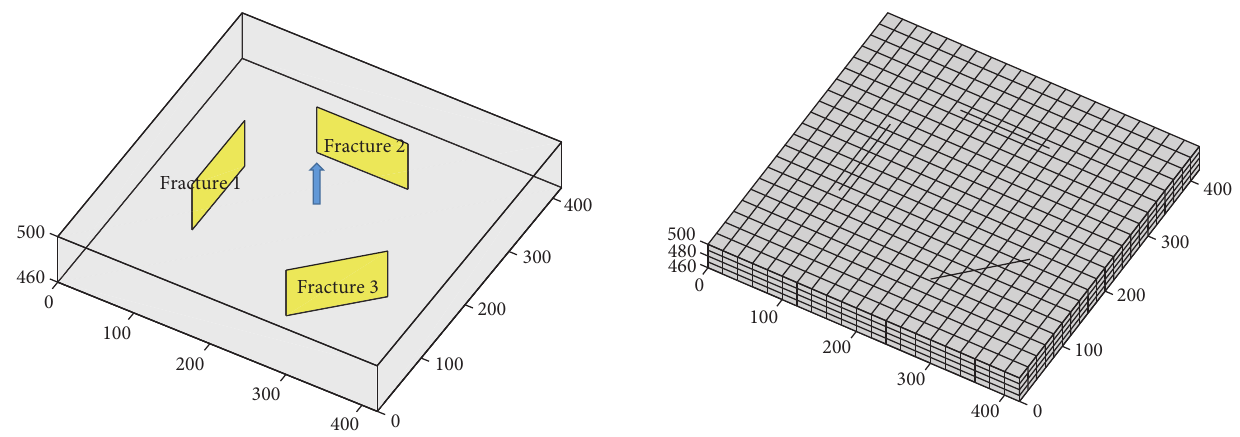
Figure 8: Configuration of the reservoir.